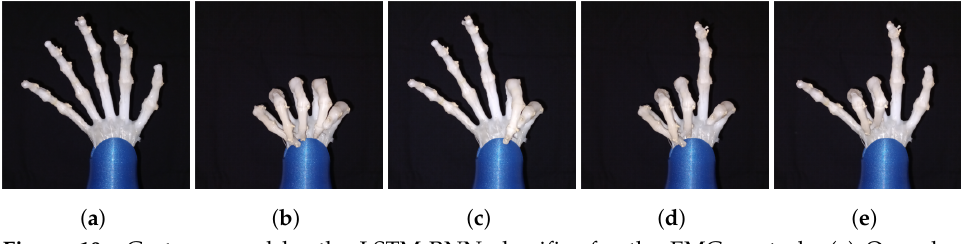
Figure 10. Gestures used by the LSTM-RNN classifier for the EMG control. ( a ) Open hand. ( b ) Closed hand. ( c ) Lateral pinch. ( d ) Signaling sign. ( e ) Rock